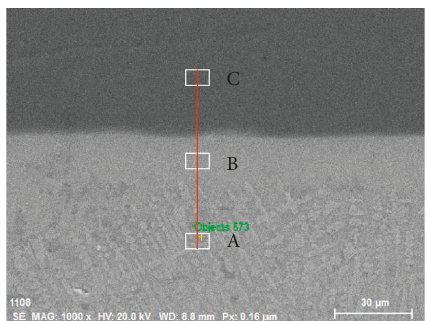
Figure 3: Location of the EDS line scanning